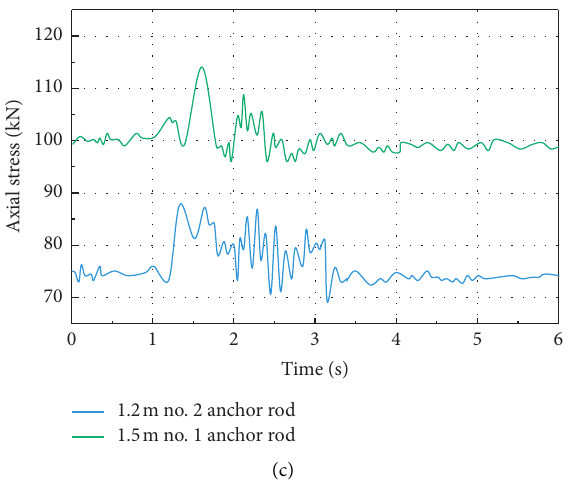
Figure 13: Comparison of surrounding rock deformation and bolt force in different schemes: (a) roof subsidence curve with different bolt spacing; (b) axial stress time history curve of A section in bolt under mine earthquake with a magnitude of 2.2; (c) axial stress time history curve of A section in bolt under mine earthquake with a magnitude of